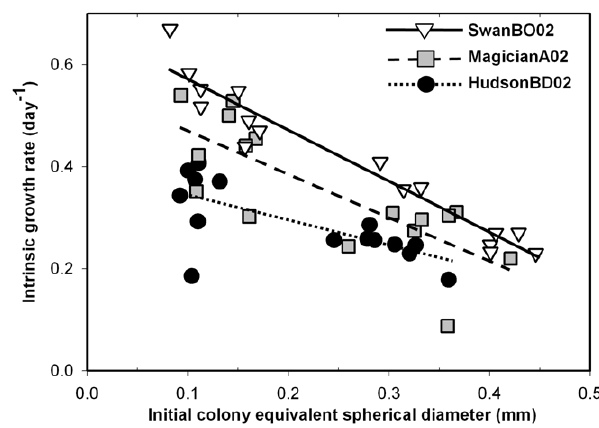
Figure 2. Patterns between Microcystis aeruginosa colony growth rate and size. Relationship between growth rate (day 2 1 ) and initial colony equivalent spherical diameter (ESD, mm) measured between days 1 and 8 for individuals of three M. aeruginosa genotypes (HudsonBD02, MagicianA02, and SwanBO02) grown in chambered microscope slides.